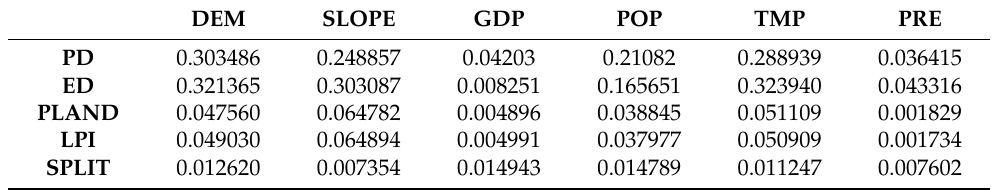
Table A2. The force (q-value) among each influencing factor on each landscape pattern metric in 2020.